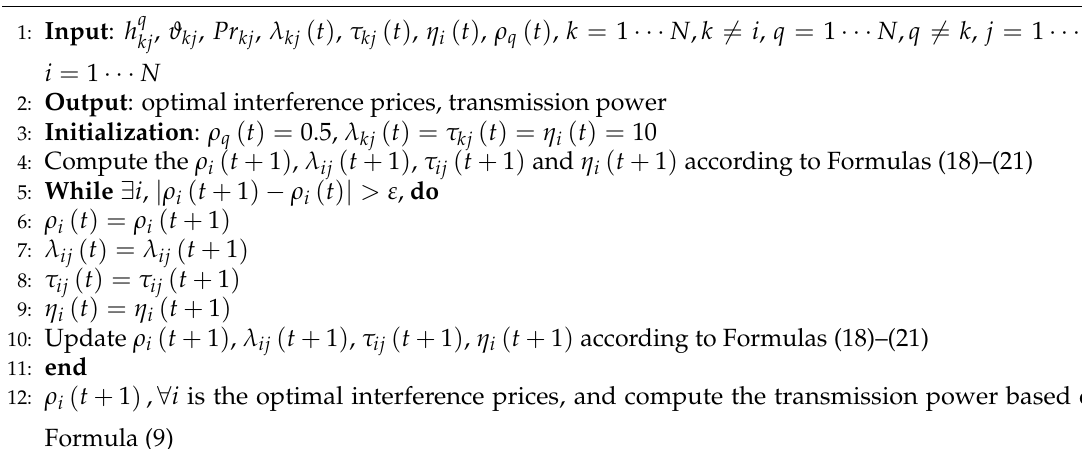
Algorithm 1 Power control algorithm.